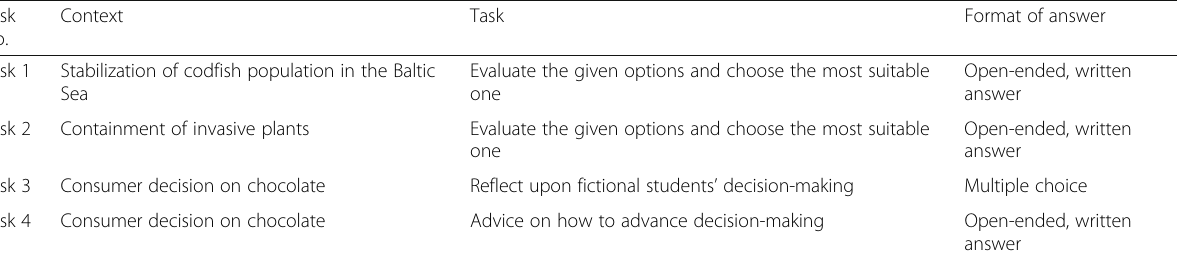
Table 2 Description of the instrument ’ s tasks Task No.